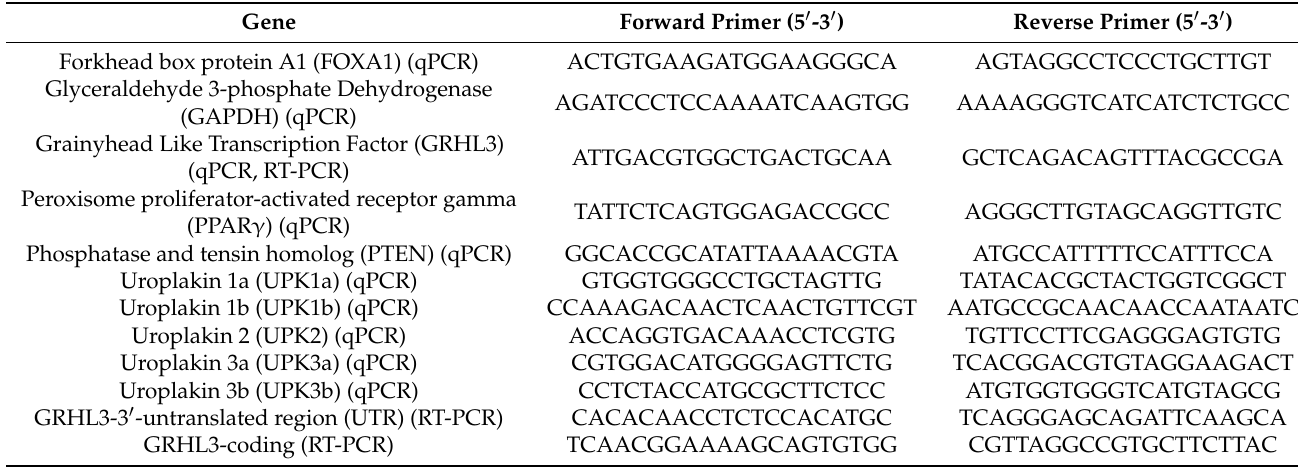
Table 2. Primer sequences for RT-qPCR.